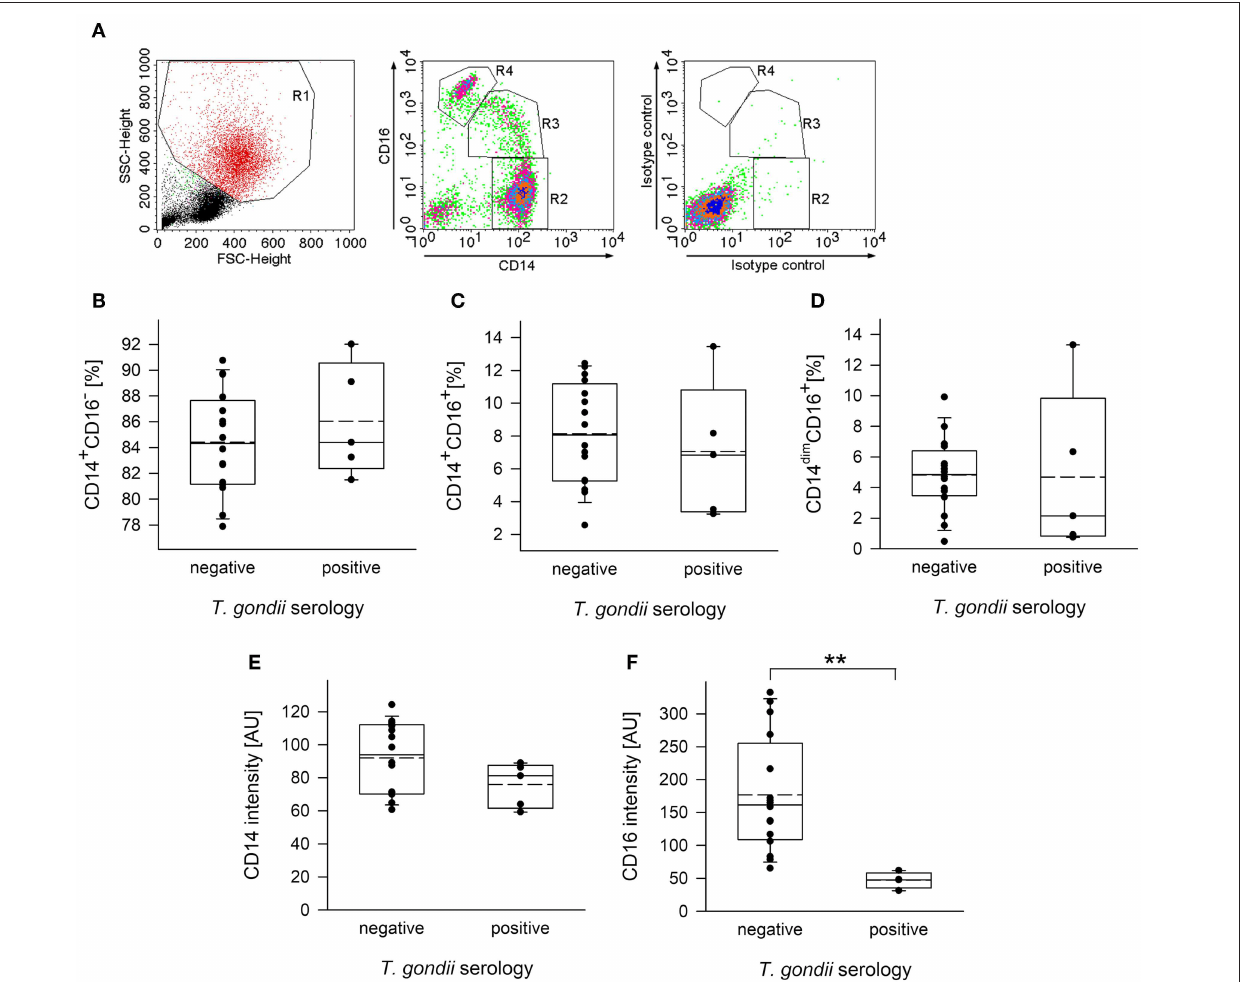
FIGURE 1 | Distribution of subpopulations and expression levels of CD14 and CD16 of monocytes from blood donors with or without chronic toxoplasmosis. PBMCs were isolated from blood by density centrifugation and were enriched for plastic-adherent monocytes. They were then stained using fluorescently labeled anti-CD14 and anti-CD16 reagents or isotype control antibodies and were FACS-analyzed. Blood donors were serologically classified as chronically T. gondii -infected or non-infected using plasma from the blood samples. (A) Representative FACS analysis of monocyte-enriched PBMCs from a T. gondii naïve blood donor showing FSC/SSC-based gating on monocytes (left panel) and CD14/CD16-based identification of classical (R2; i.e., CD14 + CD16 − ), intermediate (R3; i.e., CD14 + CD16 + ) and non-classical (R4; i.e., CD14 dim CD16 + ) monocyte subsets. Staining with isotype control antibodies is shown in the right panel. (B–D) Percentages of CD14 + CD16 − (B) , CD14 + CD16 + (C) , and CD14 dim CD16 + (D) subsets among monocytes from T. gondii seropositive or seronegative individuals. Solid and dashed lines in the box-whisker plots indicate median and mean values, respectively; circles indicate individual data points. (E,F) Expression levels of CD14 (E) and CD16